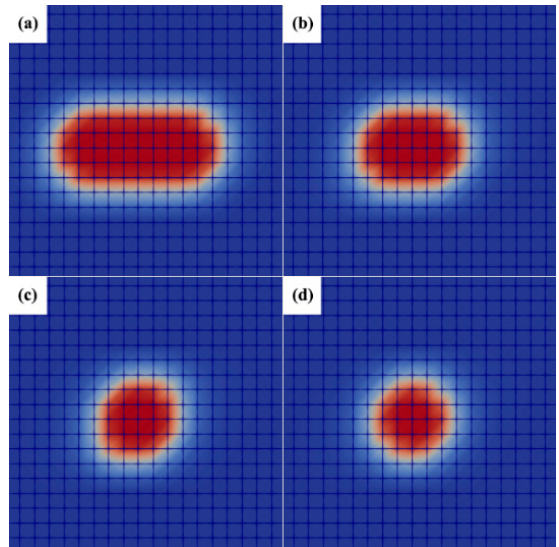
Figure 10. The healing process of the deformed void (8:2), ( a ) time = 0; ( b ) time = 100; ( c ) time = 150; ( d ) time = 175. Since the phase-field method uses dimensionless parameters, the simulation results in Figure 10 are also dimensionless.